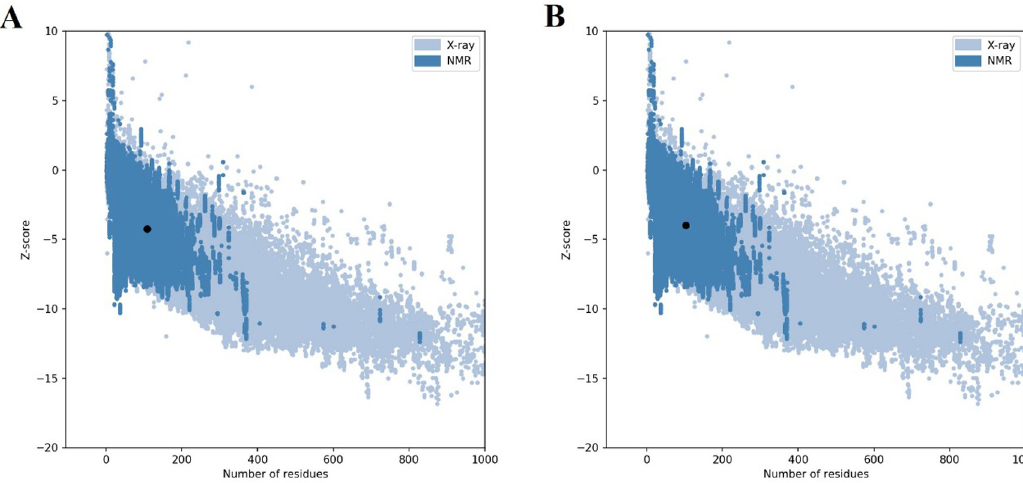
Fig 4. Z-score of A) ht-MAP2191 and B)